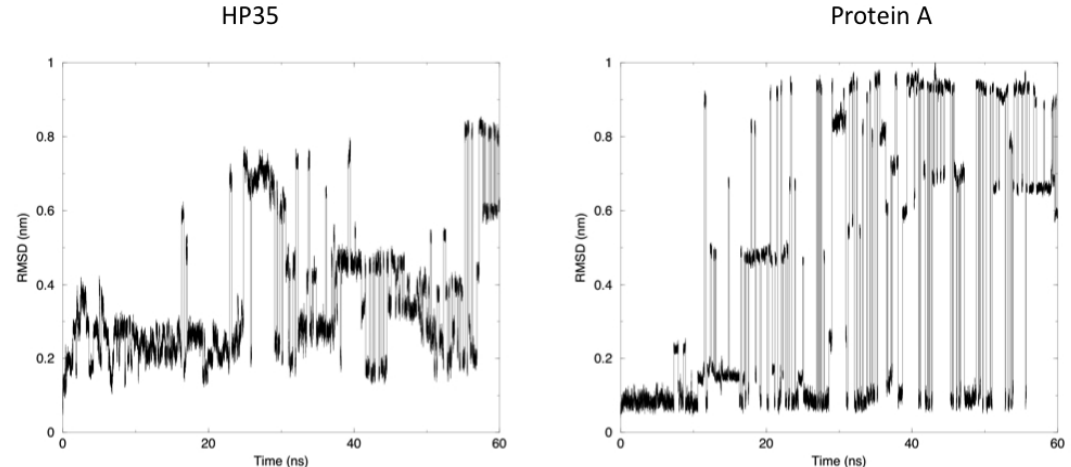
Figure 3. Time-dependent evolution of the RMSD of the backbone atoms from the reference crystal for each protein in the unmodified force-field replica.